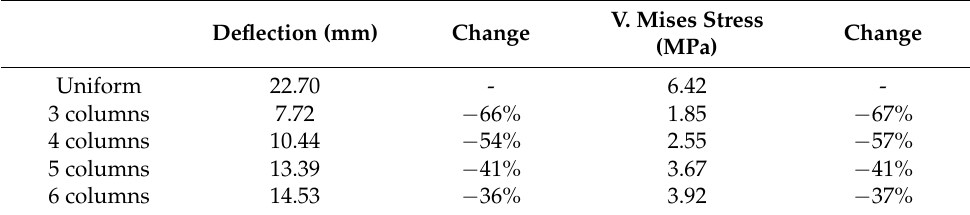
Table 8. Changes in deflection and maximum equivalent stresses from uniformly distributed loading to discrete number of